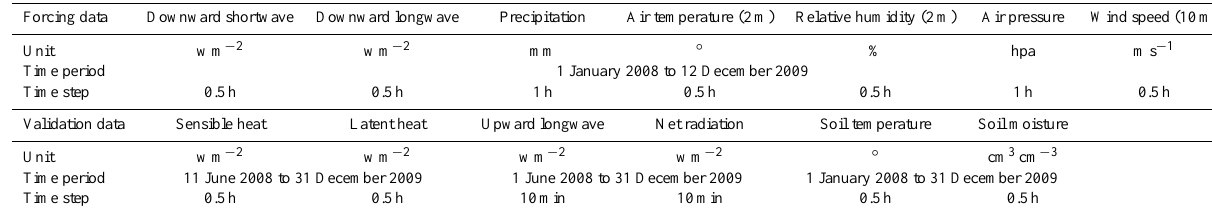
Fig. 1. The location of study area. Table 4. The forcing data and validation data taken from A’rou observation station. Forcing data